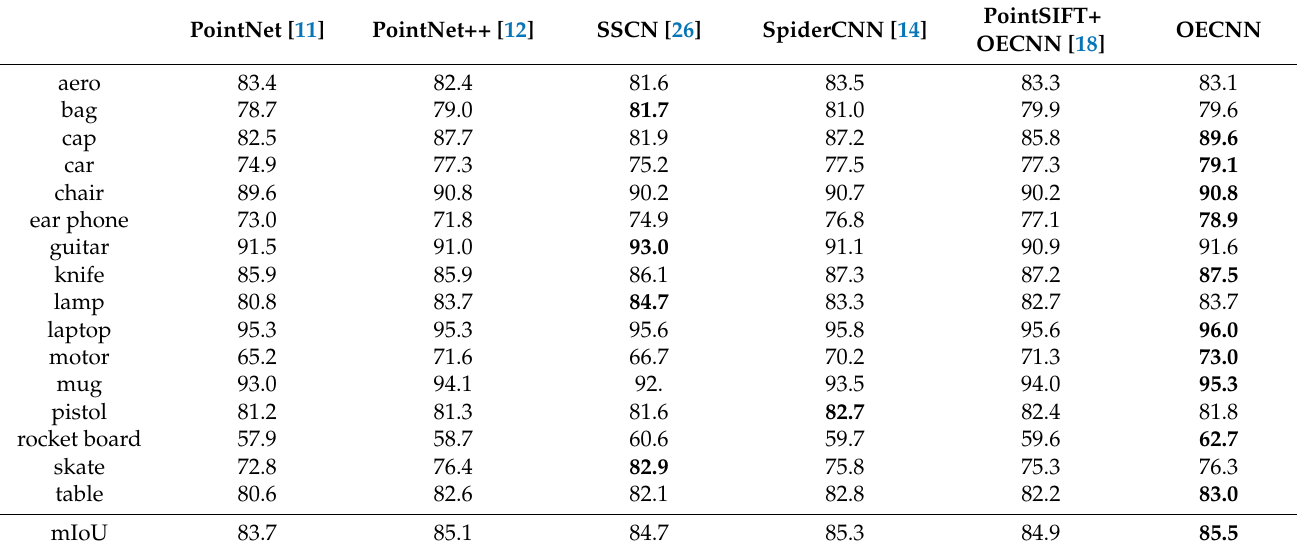
Figure 10. The architecture of OECNN in the ShapeNet Parts segmentation [6] task. Table 2. Segmentation results on the ShapeNet Parts dataset